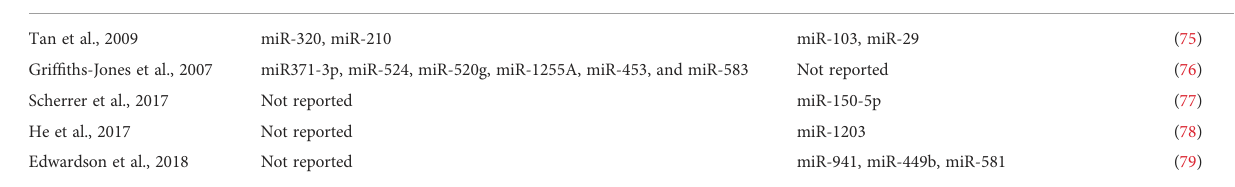
TABLE 3 Summary of miRNAs associated with